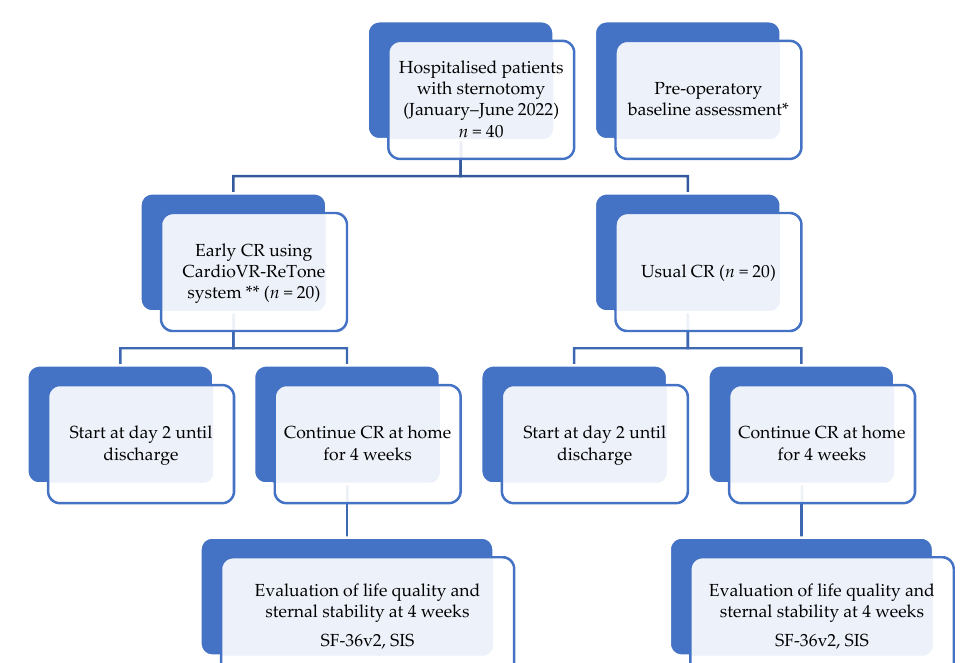
Figure 5. Patients’ randomisation algorithm. * Preoperative base-line evaluation consists of clinical evaluation, SaO 2 , ECG, CPET for aerobic capacity recording before surgery. ** During CR with CardioVR-ReTone, EMG signals will be registered, cardiac frequency, SaO 2 and pain intensity will be measured with the numerical rating scale for pain at every 5 min during the test. Pain quality will be measured using the Short Form McGill Pain Questionnaire version 2.